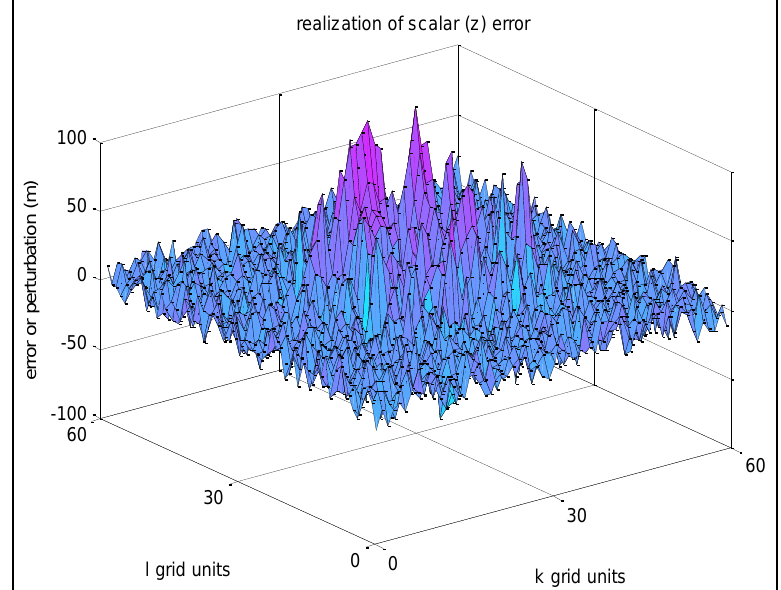
, and the individual spatial correlation functions are defined by their corresponding interpolated values for and